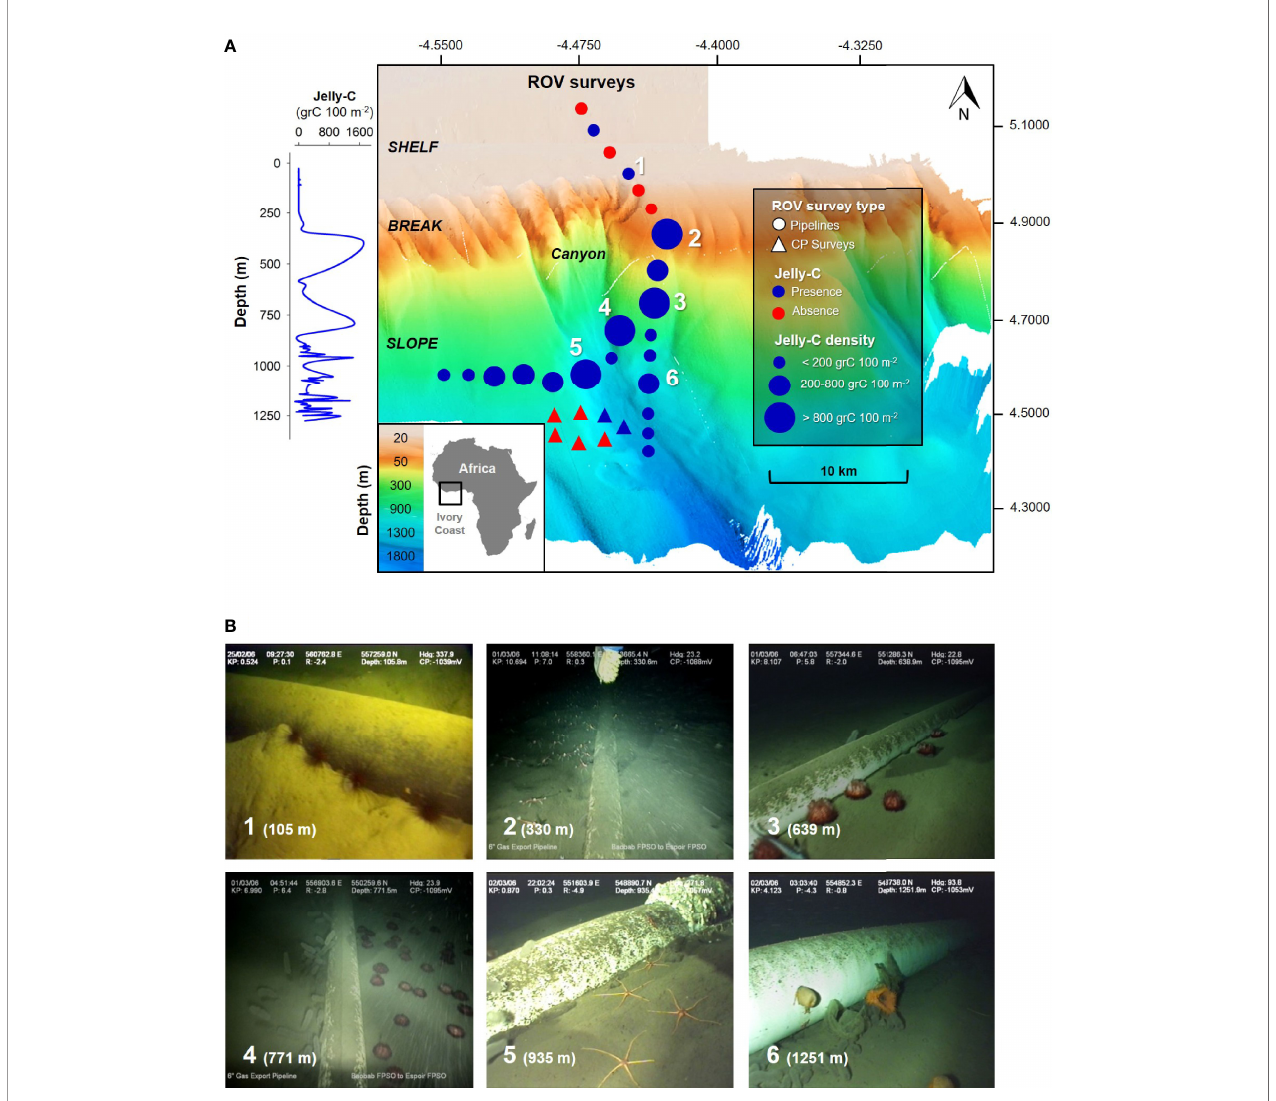
FIGURE 1 | Map of the remotely operated vehicle (ROV) benthic surveys off the Ghanaian Ivory Coast (Africa) continental margin. (A) Pyrosome jelly-C benthic observations, biomass, and carbon estimations at the sea fl oor from 20 to 1,276 m near an oil pipeline in 2006 using an ROV. Survey types include “ Pipelines ” and “ CP Surveys ” alongside a canyon. (B) Examples of megafaunal organisms ’ aggregations triggering dominance events by single species: 1, Diadema spp.; 2, Galathea sp.; 3 – 4, Phormosoma sp.; 5, Ophiolepadidae; 6, Actinostola sp. The numbers in panel A correspond to the areas of the observations/organisms in panel (B) A full taxonomic list of organisms from this study is available in Table 2 . The 3D seabed map was rendered by Sonsub technical staff and was produced from the DP Reel Vessel using multibeam